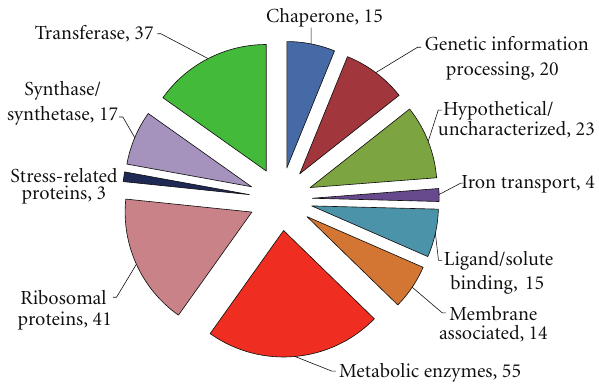
Figure 2: Functional categories of proteins identified common to all four cellular fractions of B. vietnamiensis G4. Number of proteins belonging to each category is listed along with the protein